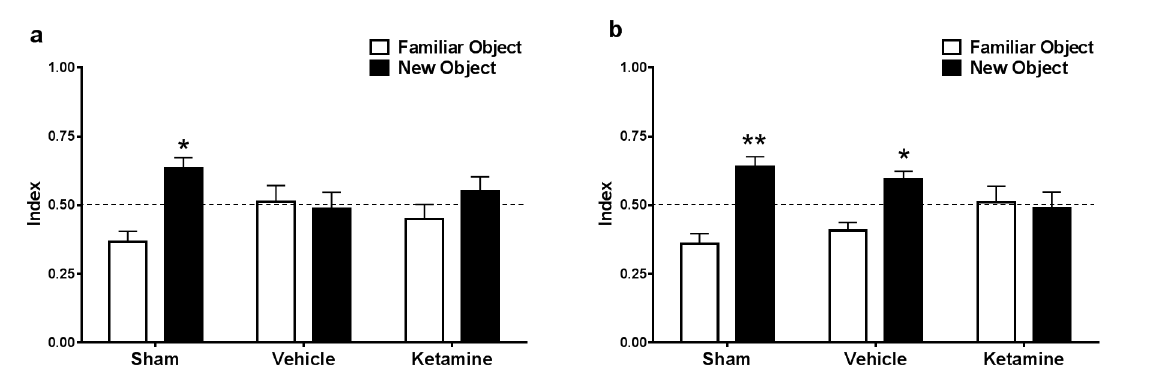
Figure 5 - Amnesic effect of ketamine (30 mg/kg/day i.p. 14 days) in the novel object recognition task. Results are expressed as mean ± S.E.M (n = 7-10). a ) Short term memory (90 min interval). b ) Long term memory (24 h interval) * p < 0.05, ** p < 0.01 on Paired Student’s t